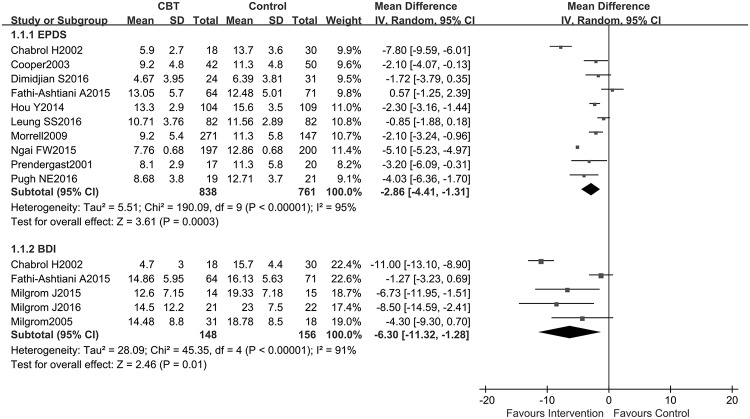
Combined results of EPDS and BDI scores comparing CBT vs. control conditions immediately post-intervention: A random effects analysis.